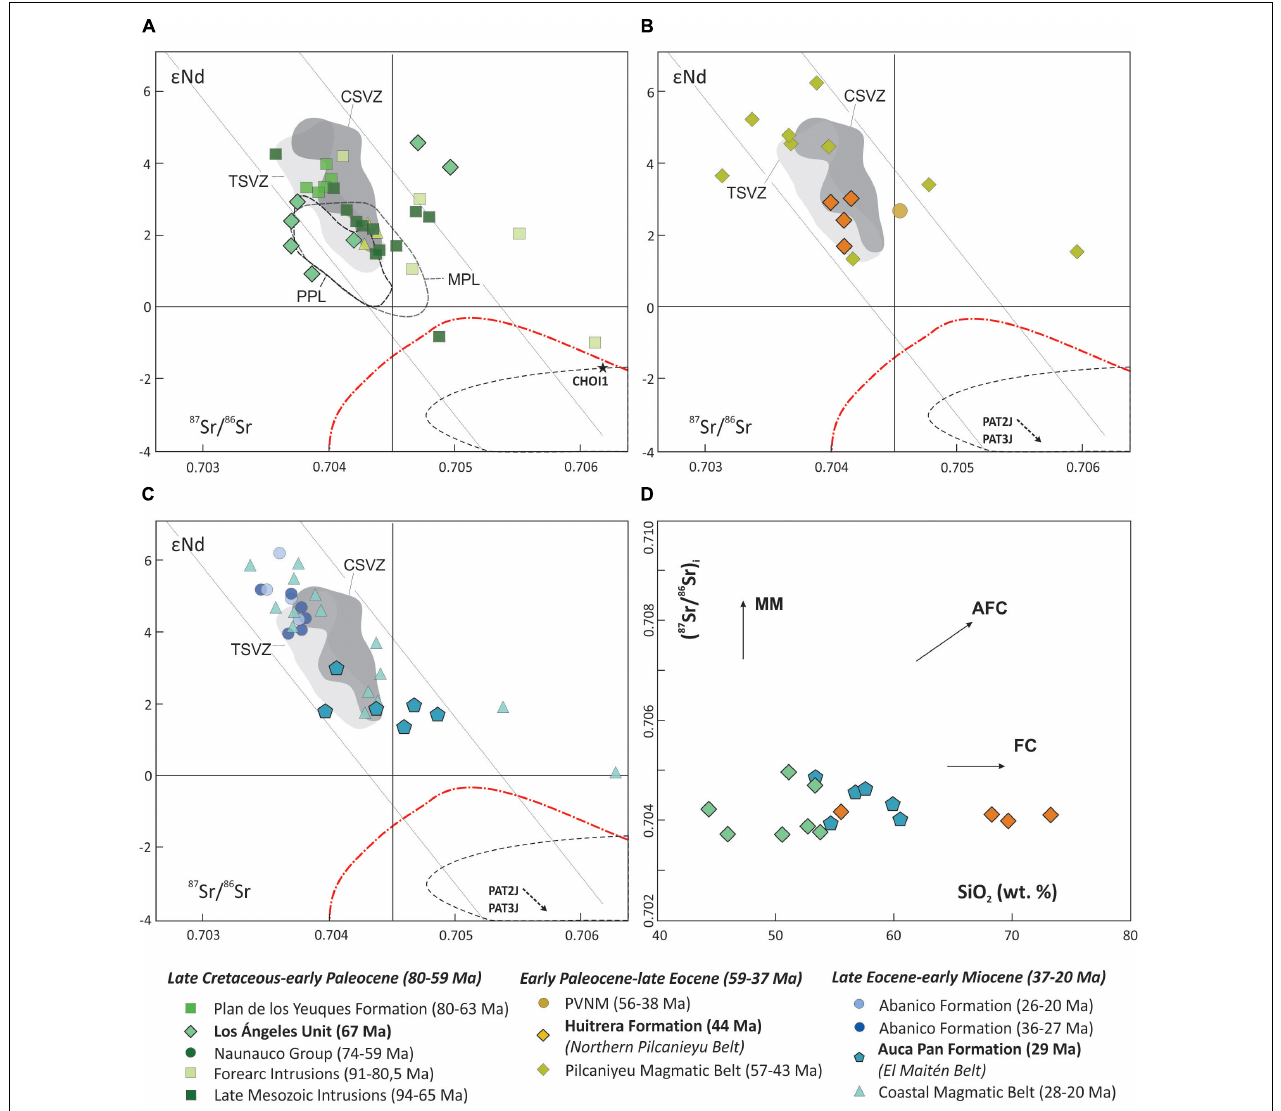
FIGURE 7 | Initial isotopic compositions for Los Ángeles Unit (A) , Huitrera Formation (B) , and Auca Pan Formation (C) . Recalculated initial isotopic ratios from coeval magmatic units are also included. CHOI1 corresponds to the Choiyoi Group considered as the local basement of the Los Angeles Unit area (35 ◦ 30 (cid:48) S), while PAT2J and PAT3J correspond to the Late Paleozoic metamorphic and igneous local basement of the Huitrera and Auca Pan Formation in the North Patagoniana Andes (39–41 ◦ S). The black dashed line corresponds to the Southern Coastal Batholith 30–38 ◦ S (Parada et al., 1988; Lucassen et al., 2004), while the red dashed line corresponds to the Metamorphic basement and Late Paleozoic intrusions that represent the Pz basement of the region (Lucassen et al., 2004; Pankhurst et al., 2006). The Transitional Southern Volcanic Zone (TSVZ) isotopic data are from Mella et al. (2005) while Central Southern Volcanic Zone (CSVZ) data are taken from López-Escobar et al. (1992, 1995). The acronyms PPL and MPL correspond to post-plateau lavas and main-plateau lavas that represent the Neogene Patagonian slab window lavas studied by Gorring and Kay (2001). (D) 87 Sr/ 86 Sr vs. SiO 2 (wt.%) showing the AFC (assimilation and fractional crystallization), FC (fractional crystallization), and MM (mantle metasomatism)